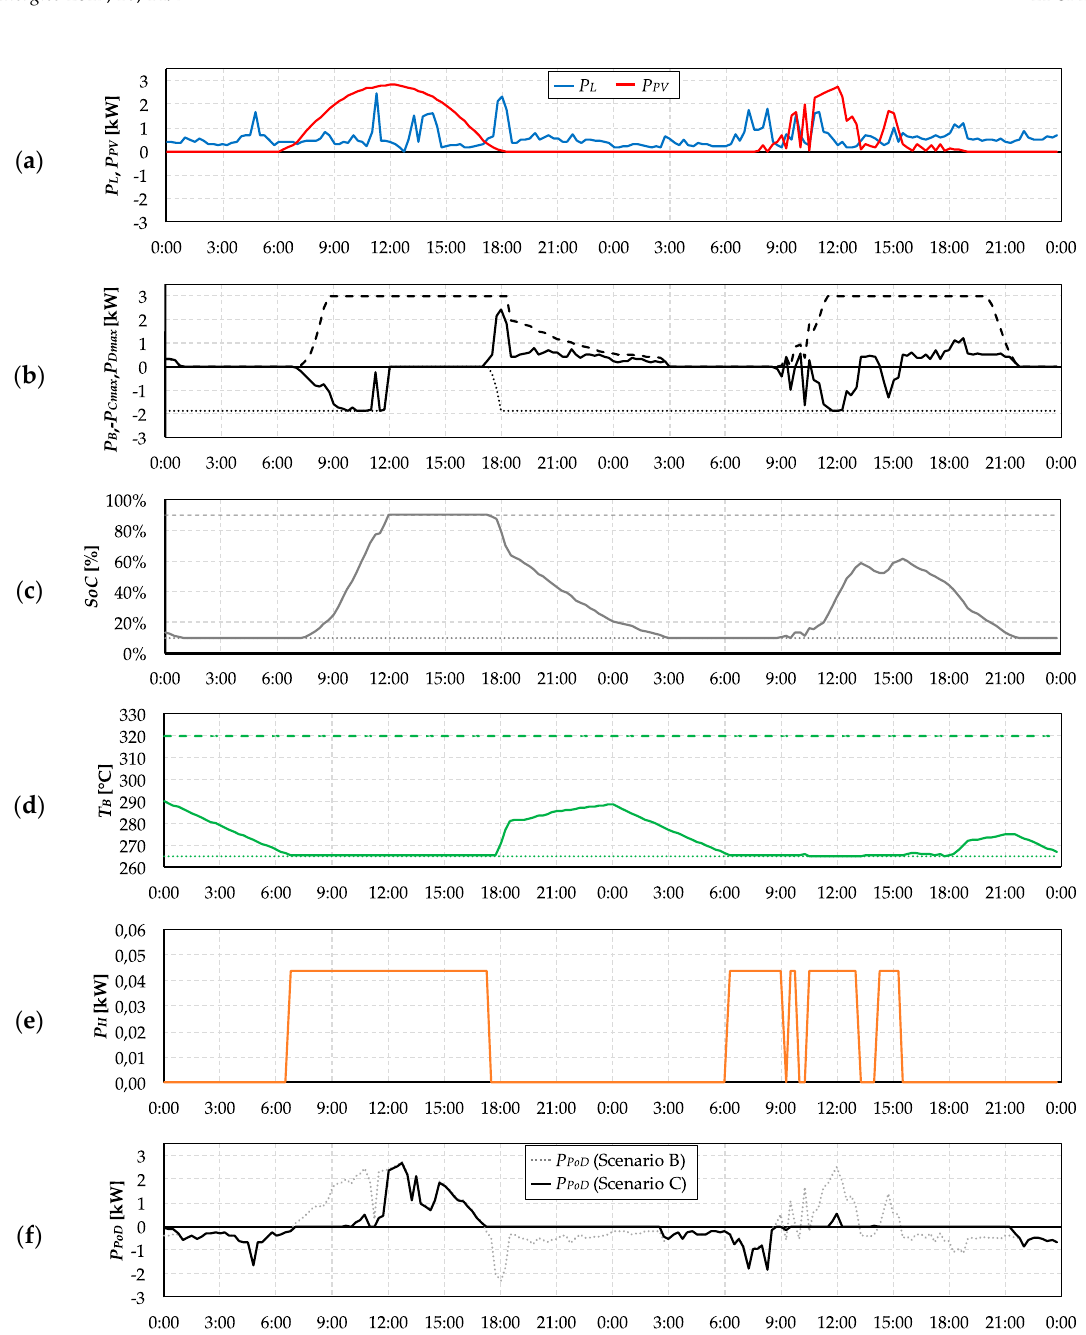
Figure 5. Graphical representation of the BESS operation during a couple of spring days (24 and 25 March). ( a ) PV generation (red line) and load consumption P L ( t ) (blue line); ( b ) Battery power flow P B (t) (bold black line), dynamic charging constraint − P Cmax ( t ) (dotted black line) and dynamic discharging constraint P Dmax ( t ) (dashed black line); ( c ) State of Charge time trend SoC(t) (bold grey line) and its admitted range defined by SoC m and SoC M (dotted line and dashed line, respectively); ( d ) Internal temperature behavior T B ( t ) (bold green line) and its admitted range defined by T m and T M (dotted line and dashed line, respectively); ( e ) Battery heater power absorption P H (t) ; ( f ) Power exchange time trend P PoD ( t ) in cases where the BESS is operative (bold black line) or not (dotted grey line).